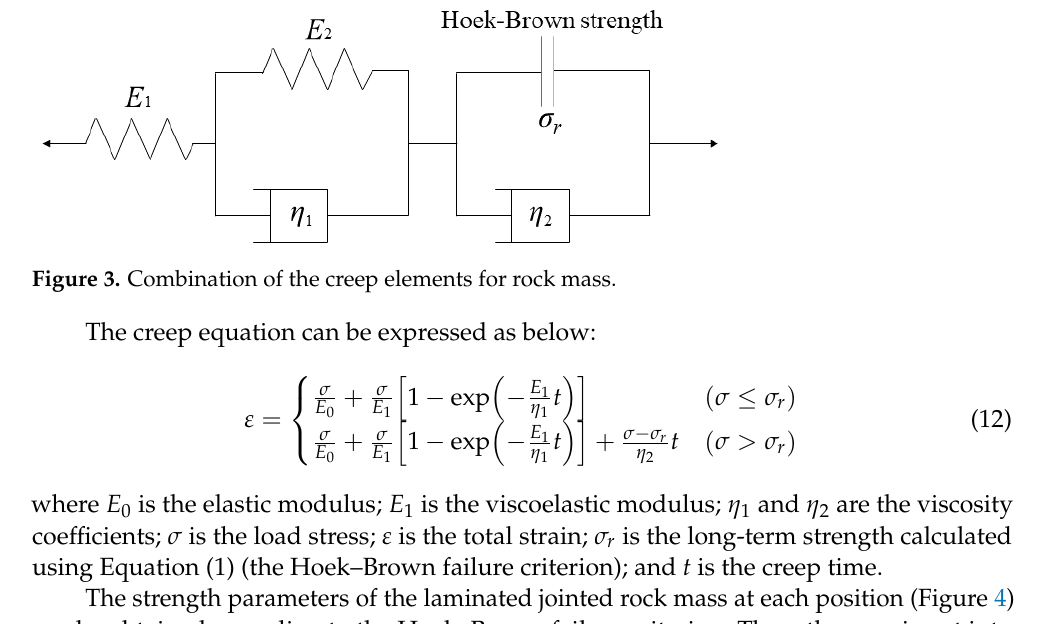
9 of 21 Figure 2. GSI quantification of rock mass [31]. Note: The following example is used to demonstrate how to use the above table. In the case of AWI = 0.52 and RBI = 9.7, two vertical and horizontal lines are drawn according to the index values (the dashed lines in the table); the intersection point is found between 40 and 45; the GSI value at the point is calculated via linear interpolation (the result is 41).